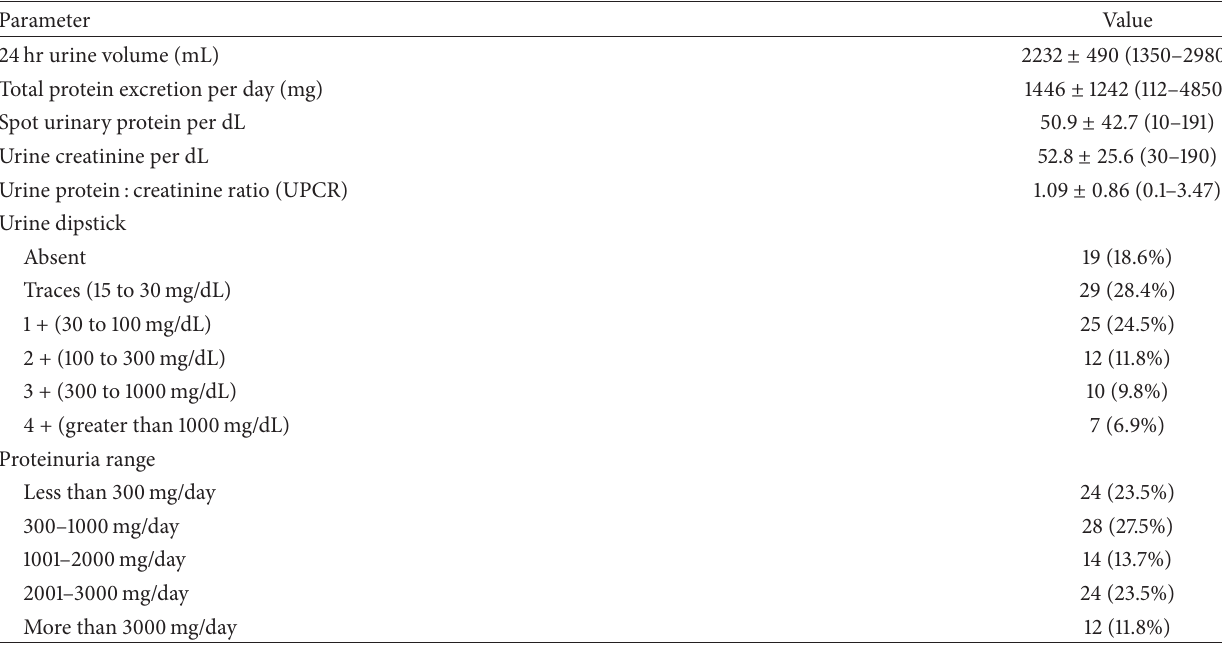
Table 2: Laboratory evaluation.